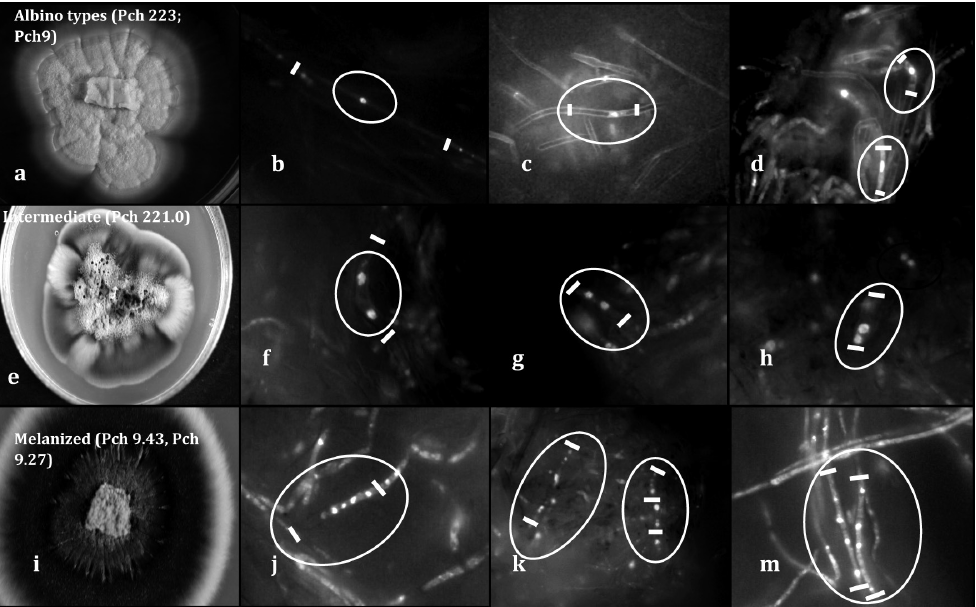
Figure 3. Nuclear condition of the strains representing the five morphotypes recognized among a collection of 57 Spanish isolates of P. chlamydospora ; a-d, albino types; e–h, intermediate forms; i-m, melanised types. Septa of hyphal cell walls have been highlighted